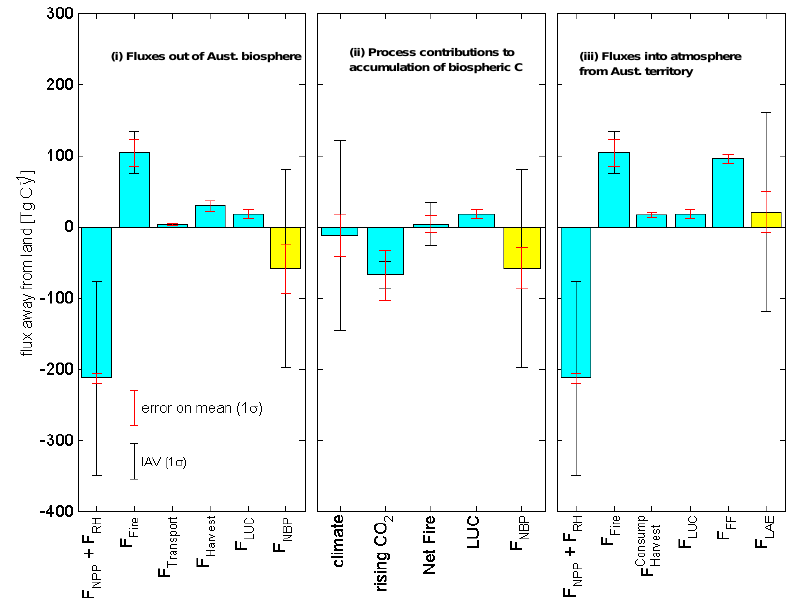
Figure 2. (i) Net flux of carbon out of the Australian biosphere (FNBP, yellow) as the sum of components (blue); (ii) net flux of carbon out of the Australian biosphere ( F NBP , yellow) as the sum of process contributions (blue) due to variable climate, rising CO 2 , net effect of fire (excluding clearing fires) and LUC (including clearing fires); and (iii) net flux of carbon from the Australian territory to the atmosphere ( F LAE , yellow), as the sum of components (blue). Error bars represent errors on the mean (1 σ , red) and interannual variability (1 σ ,